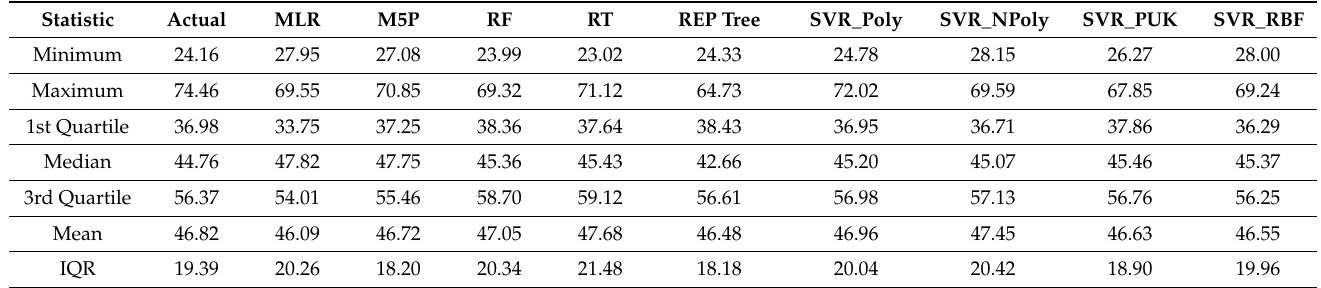
Table 7. Descriptive statistics results of actual and predictive values of compressive strength of concrete